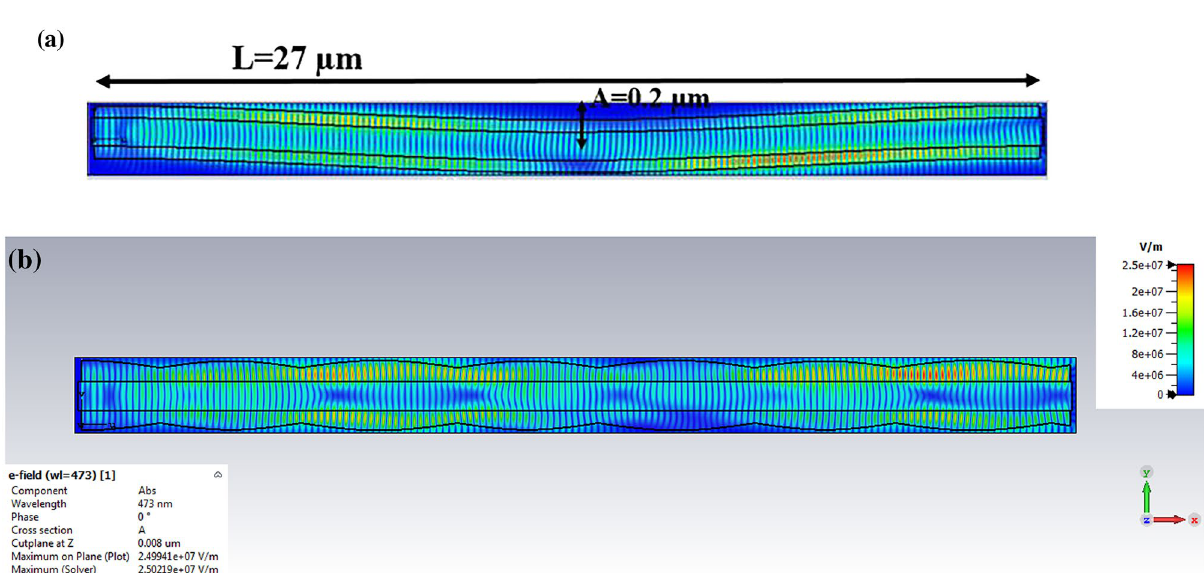
Figure 12. Distribution of the electric field of the myelinated axon while light is launched to the myelin sheath with a ( a ) nerve fiber with bending, and ( b ) nerve fiber with myelin sheath